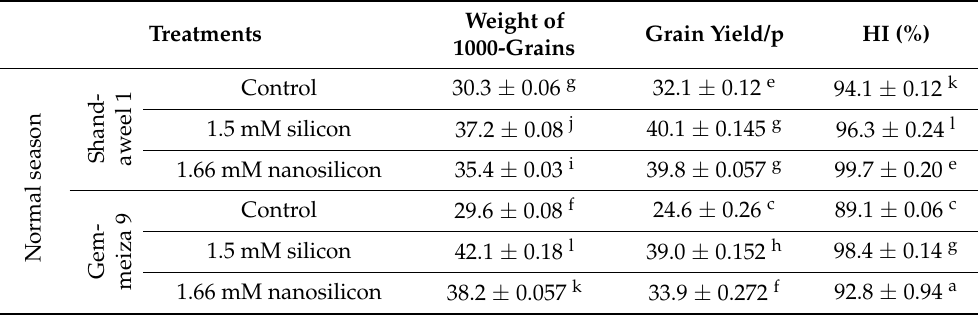
Table 2. Effects of silicon and nanosilicon on yield components (Weight of 1000-grains, Grain yield/p, HI) of two wheat cv. Shandaweel 1 and cv. Gemmeiza 9 at normal and late seasons. Each value is the main of 10 different replicates ±